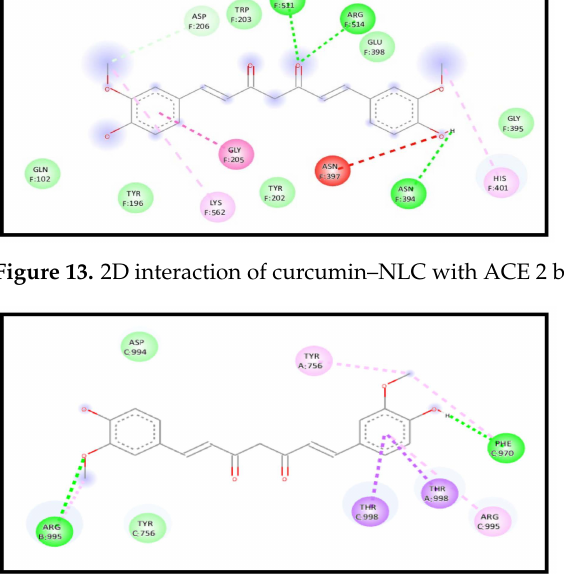
Figure 14. 2D interaction of curcumin–NLC with ACE 2 binding receptor (7KNB) in a complex.